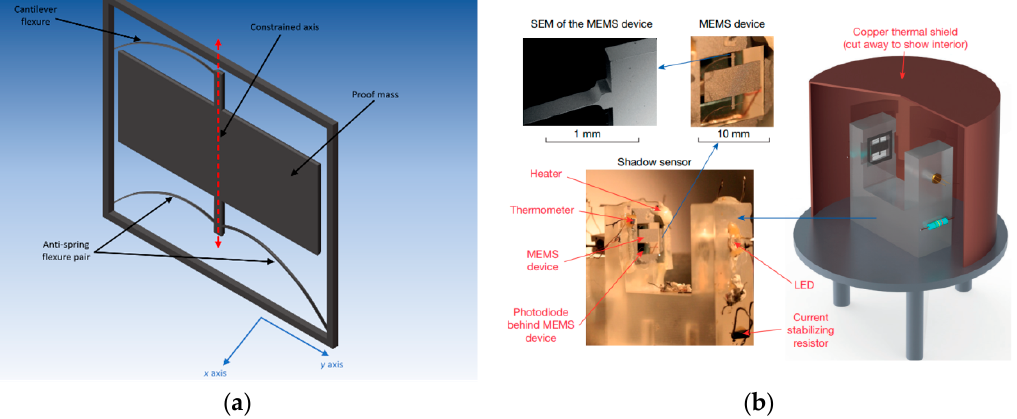
Figure 4. Schematic diagrams of MEMS accelerometer and experimental setup developed by Middlemiss et al. at University of Glasgow [17]: ( a ) schematic diagram of the MEMS accelerometer—central proof mass was suspended from three flexures: an anti-spring pair at the bottom and a curved cantilever at the top; ( b ) experimental setup. (Figure 4a is redrew by the authors)